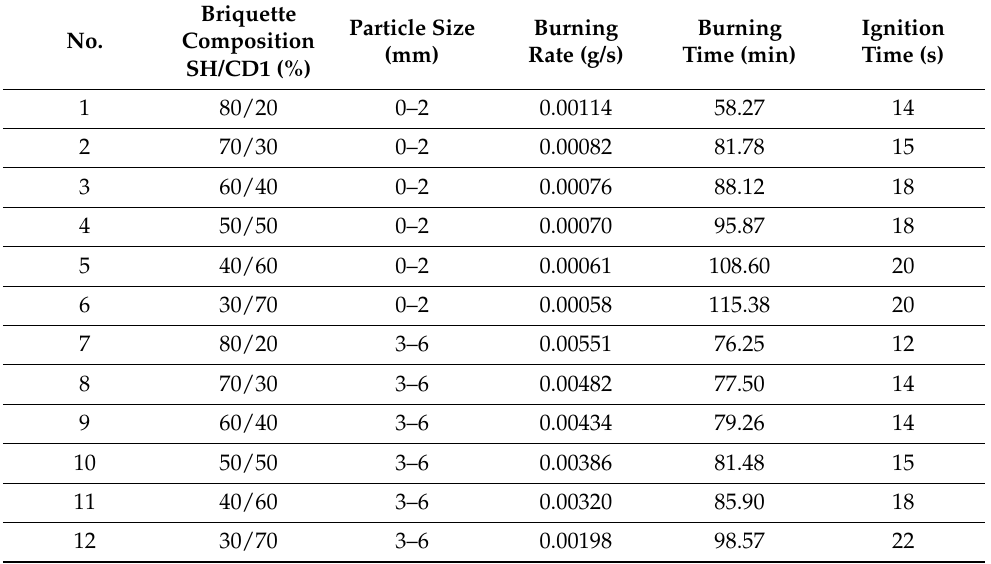
Table 5. The result of burning rate, burning time and ignition (sunflower husk and Shubarkul coal dust).